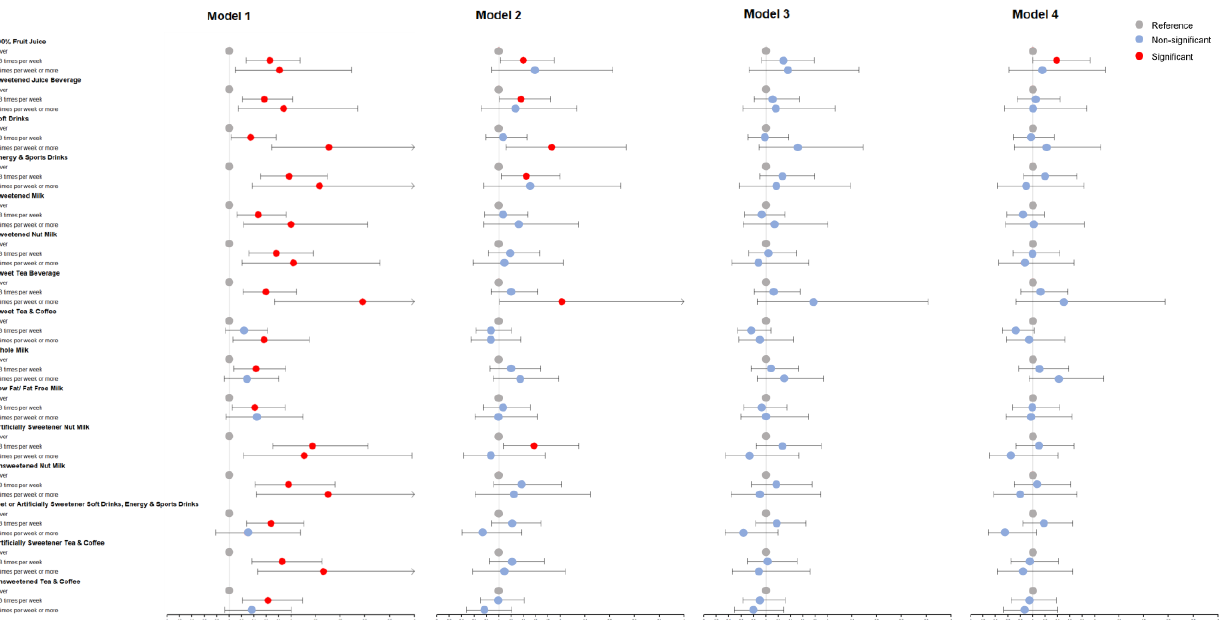
Figure 2. Association between different types of beverage intake frequency and male pattern hair loss (MPHL). Model 1 had no adjustment for confounders; Model 2 adjusted: age, education level, BMI, smoking status, alcohol intake, family history, hair dyeing/perming/bleaching/relaxing, sleep time and physical activity; Model 3, based on model 2, further adjusted consumption of vegetables, meats, eggs, beans and bean products, oils and fats, deep fried food, sugar and honey, sweets and ice cream; Model 4, based on model 3, further adjusted PTSD.